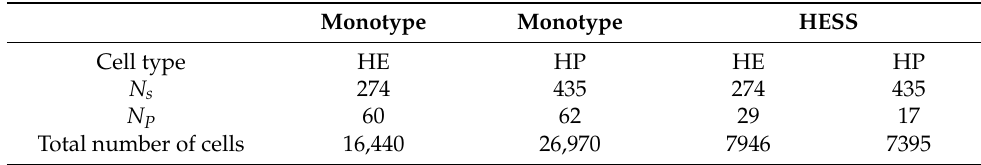
Table 2. The number of cells in each battery topology.